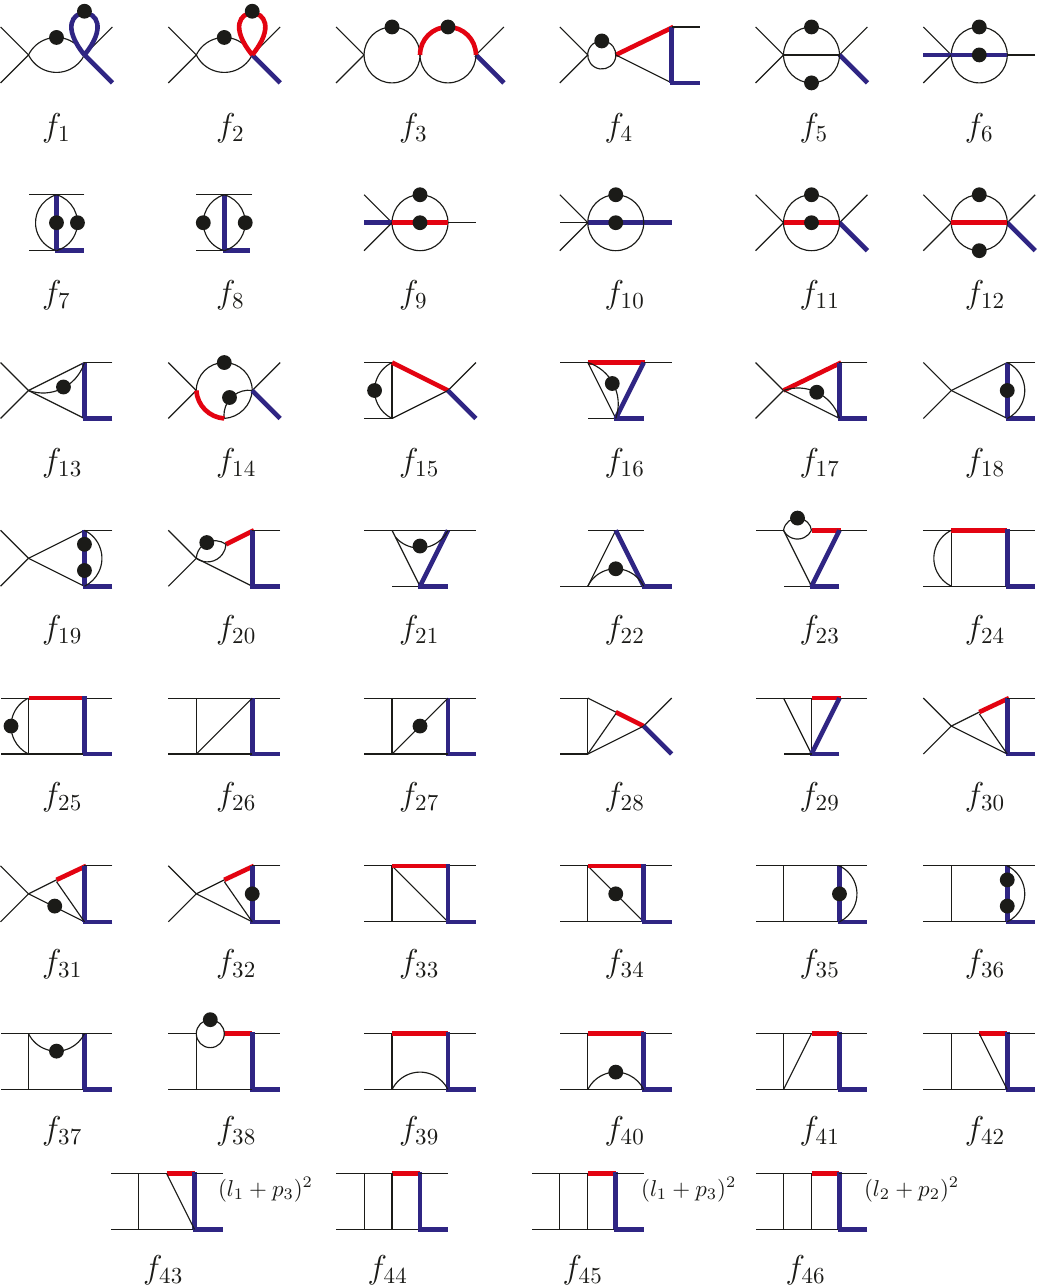
Figure 2. A set of pre-canonical MIs. The thin and thick lines represent massless and massive external particles and propagators respectively (red for W boson and blue for charged lepton). One dot means the index of that propagator is raised to 2 and two dots go for 3